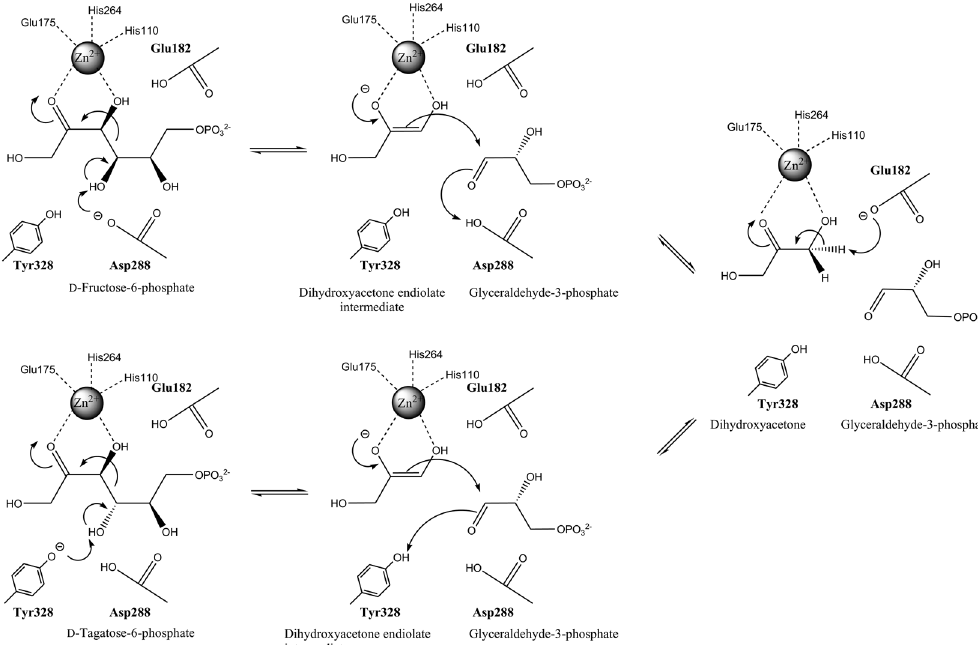
Figure 4. Proposed mechanism of FbaA for reversible 4-epimerization. Asp288 or Tyr328 deprotonates the C4-OH of F6P or T6P, splitting F6P or T6P into the enediolate of DHA and G3P. The neutral or acidic form of Glu182 on the opposite face protonates or deprotonates the C3 in the enediolate of DHA or DHA,